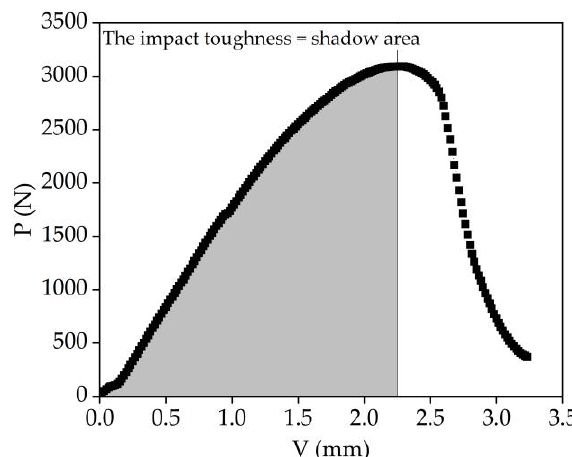
Figure 3. Calculation diagram of impact toughness by the area integral method.